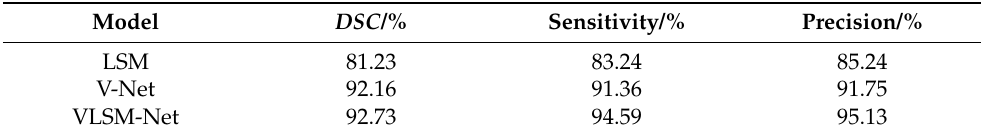
Table 1. Results of the different algorithm models in LiTS17.